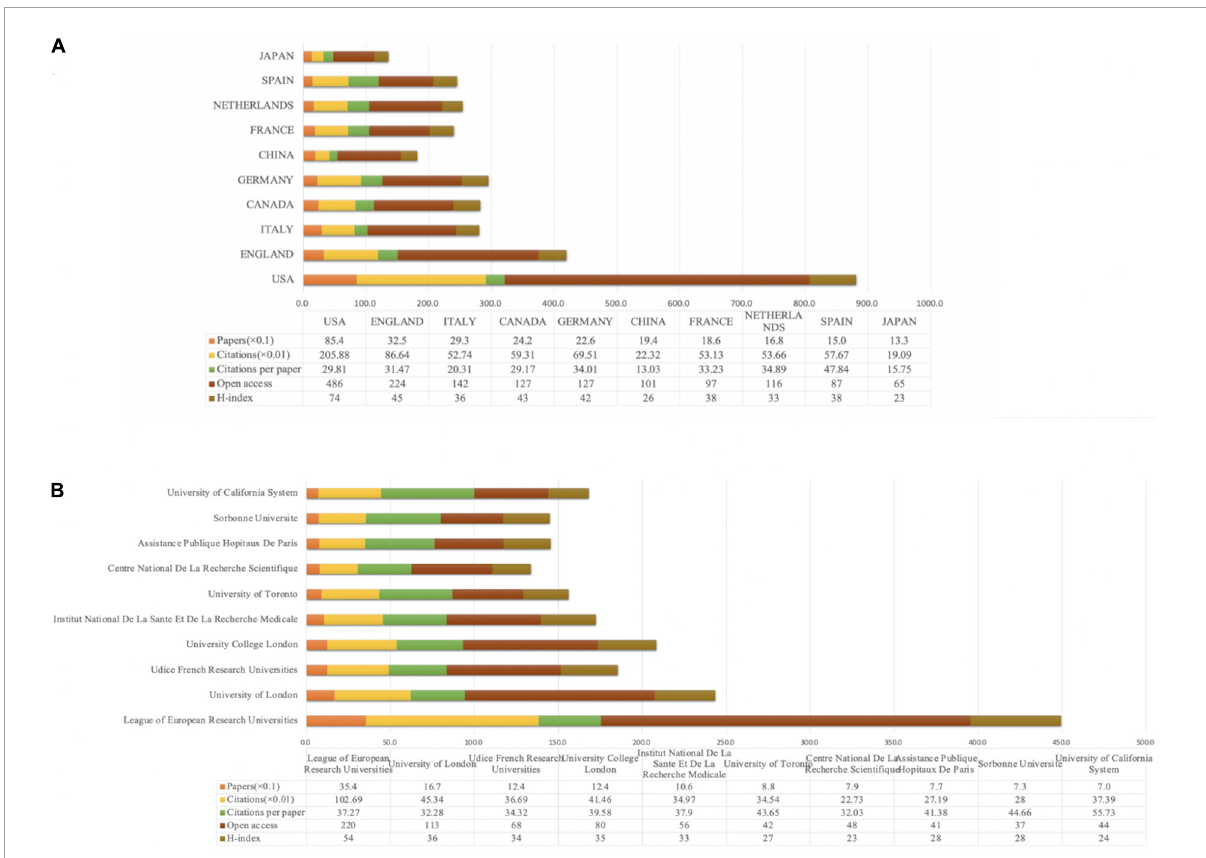
FIGURE4 Exercise on the number of publications, citations, average per item, open access, and h-index for countries (A) and institutions (B) that publish articles in the field of movement disorders.